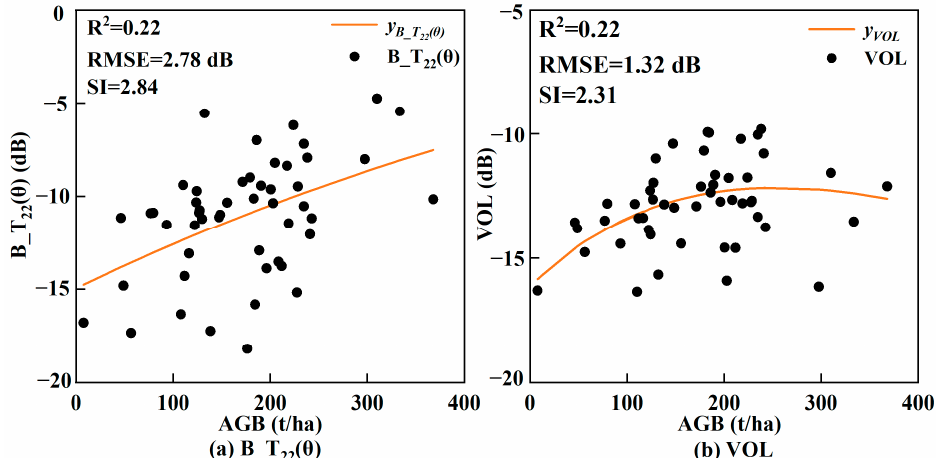
Figure 13. The plots of SI with different features.